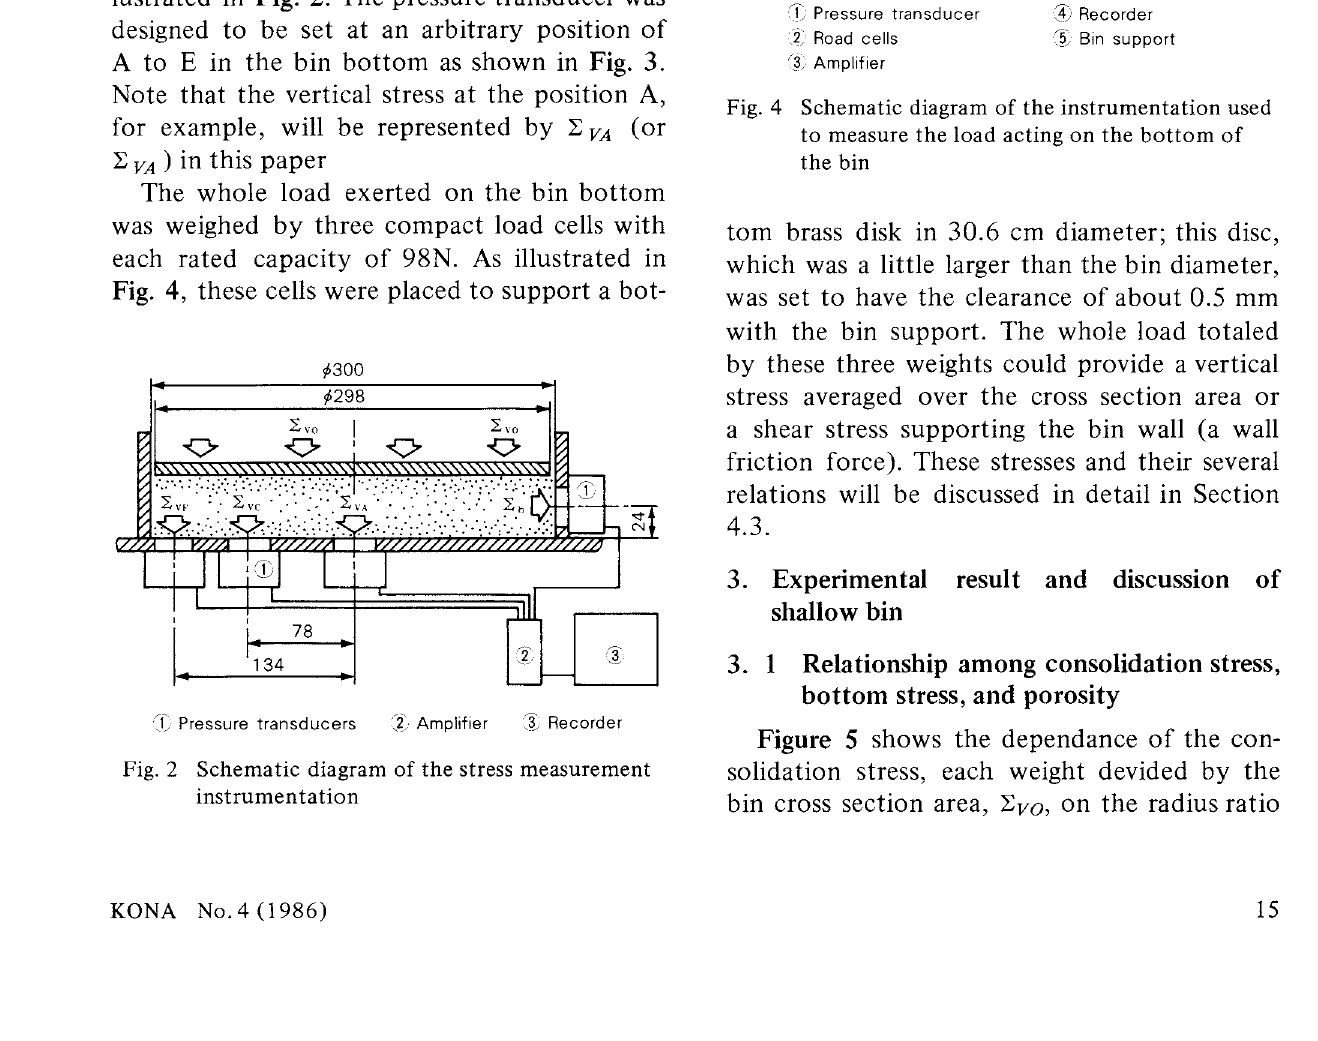
Fig. 3 Positions of the pressure transducers